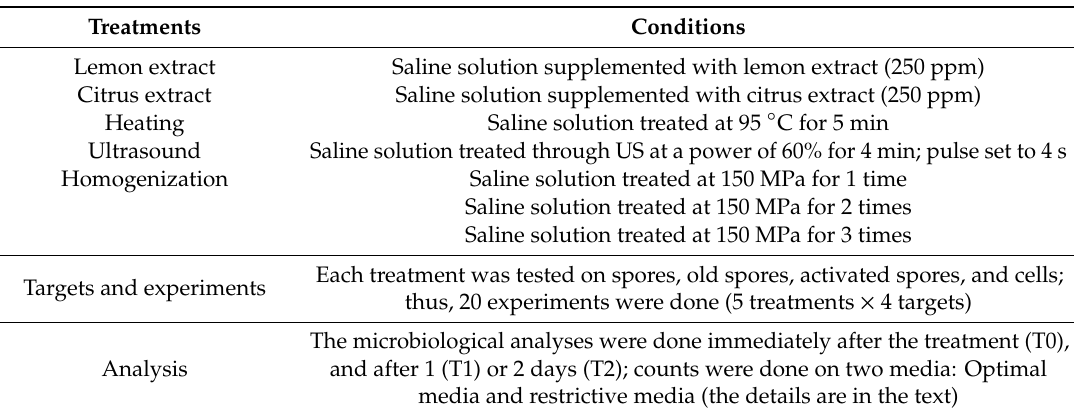
Table 1. Overview of the